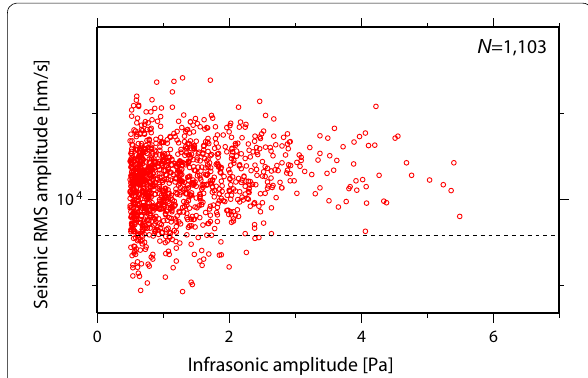
Fig. 14 Relationship between the infrasonic and seismic RMS amplitudes as measured at OWD station. The seismic RMS amplitude was estimated using 1-s three-component velocity waveforms from immediately before the infrasonic onsets that occurred from 04:05 to 05:30 on July 1. The dashed horizontal line indicates the seismic RMS amplitude before the eruptive activity on 04:05:23 on July 1 (time period indicated by the blue line in Fig.